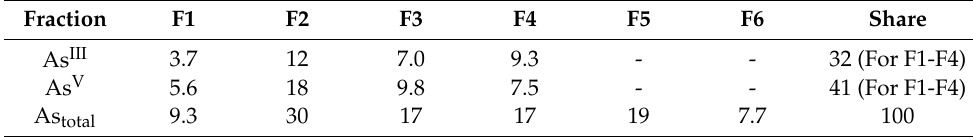
Table 5. Distribution of arsenic species in leach fraction solutions.